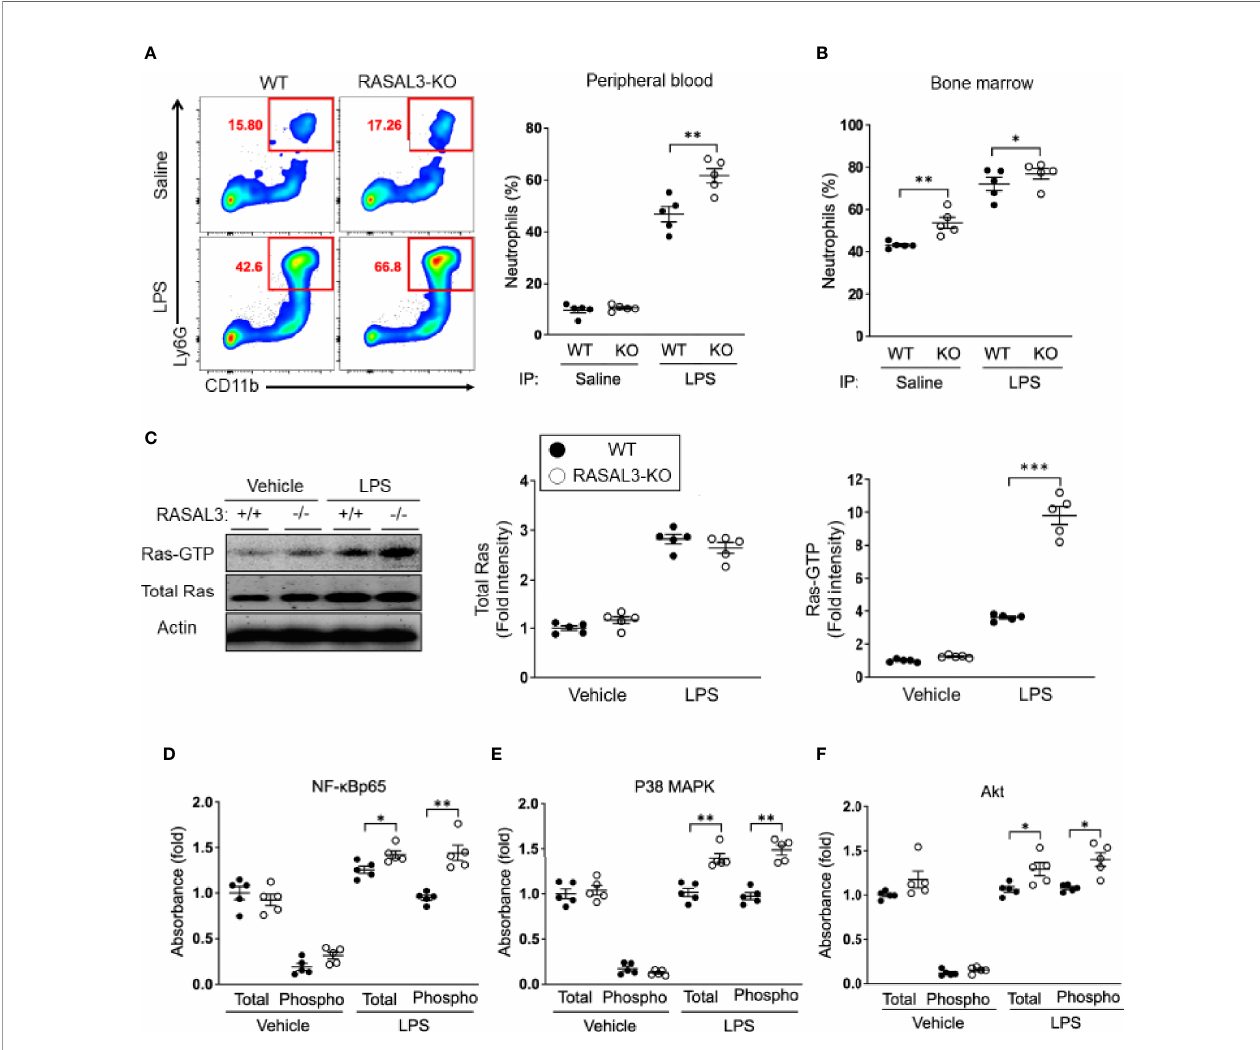
FIGURE 2 | RASAL3 functions as a RasGAP to regulate Ras signaling in neutrophils. (A, B) Assessment of neutrophil numbers in RASAL-KO and WT after LPS challenge. Mice received i.p. injection of LPS or saline (vehicle control). After 24 h, peripheral blood and bone marrow was collected, and neutrophil population (Ly6G+CD11b+ cells) were analyzed by fl ow cytometry. Representative fl ow cytometric plots are shown, along with percentage of neutrophils in the peripheral blood in (A) . Bone marrow neutrophil frequency are indicated in (B) . (C) Bone marrow (BM) isolated neutrophils were treated with LPS or vehicle control at 37°C for 30 min. Cell lysates were then harvested for Western blot after pull down assays. Active Ras (Ras-GTP) was collected by pull-down. Ras-GTP in the sample and total Ras in whole cell lysate were detected by western blot (WB). A representative image of WB (left) and fold intensities of total Ras (middle) and Ras-GTP (right) in the WB is shown. (D – F) Assessment of activation level of downstream in fl ammatory signaling factors in neutrophils. Both total and phosphorylated levels of NF- k B p65 (D) , p38 MAPK (E) and Akt (F) in cell lysate were detected by ELISA. Data are shown as the mean ± SEM of fi ve samples from one of two independent experiments. Each symbol represents data from one mouse. * p < 0.05, ** p < 0.01 and *** p <